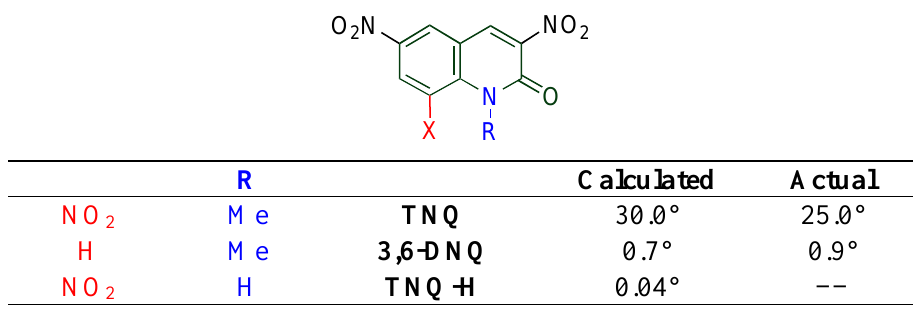
Table 9. Dihedral angles between N1-R and C8-X